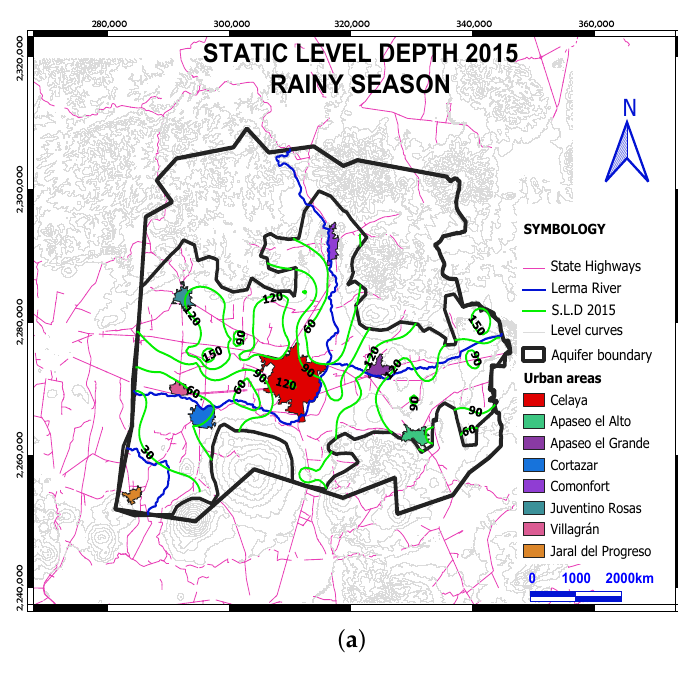
Figura 1.17: Temporada de Lluvias: Profundidad del nivel est´atico en el a˜no 2015. Figure 7. Cont Para la configuraci´on de elevaci´on del nivel est´atico del a˜no 2015 se observan las tres